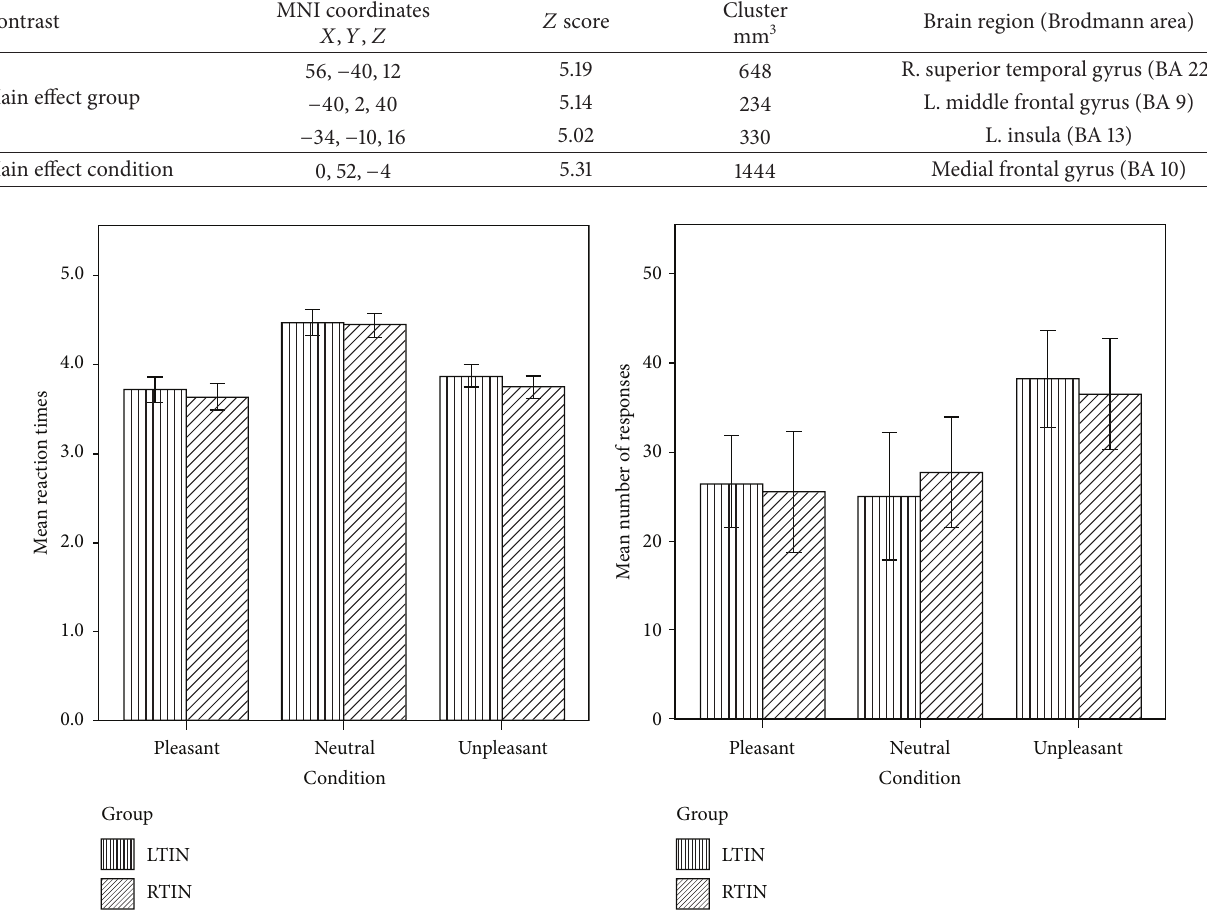
Table 3: Local maxima forthemaineffect ofgroup andcondition intheemotion taskexperiment. Regionsarelistedin MontrealNeurological Institute (MNI) coordinates. Brodmann areas are also provided (before determining the Brodmann areas, the MNI coordinates were converted to Talairach coordinates). Statistical threshold was set at 𝑝 < 0.025 FWE corrected for multiple comparisons. L: left; R: right.